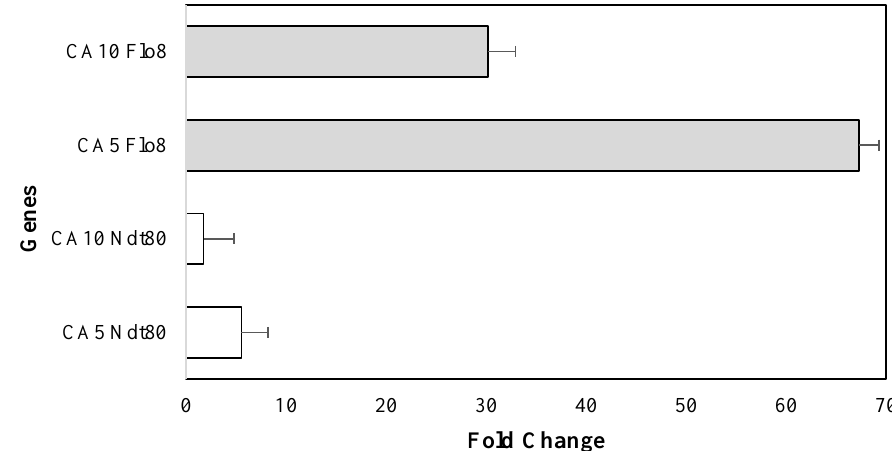
Figure 2: Fold change analysis of the expression of Flo-8 and Ndt80 after treatment with FGE (5 mg/mL and 10 mg/mL) derived from